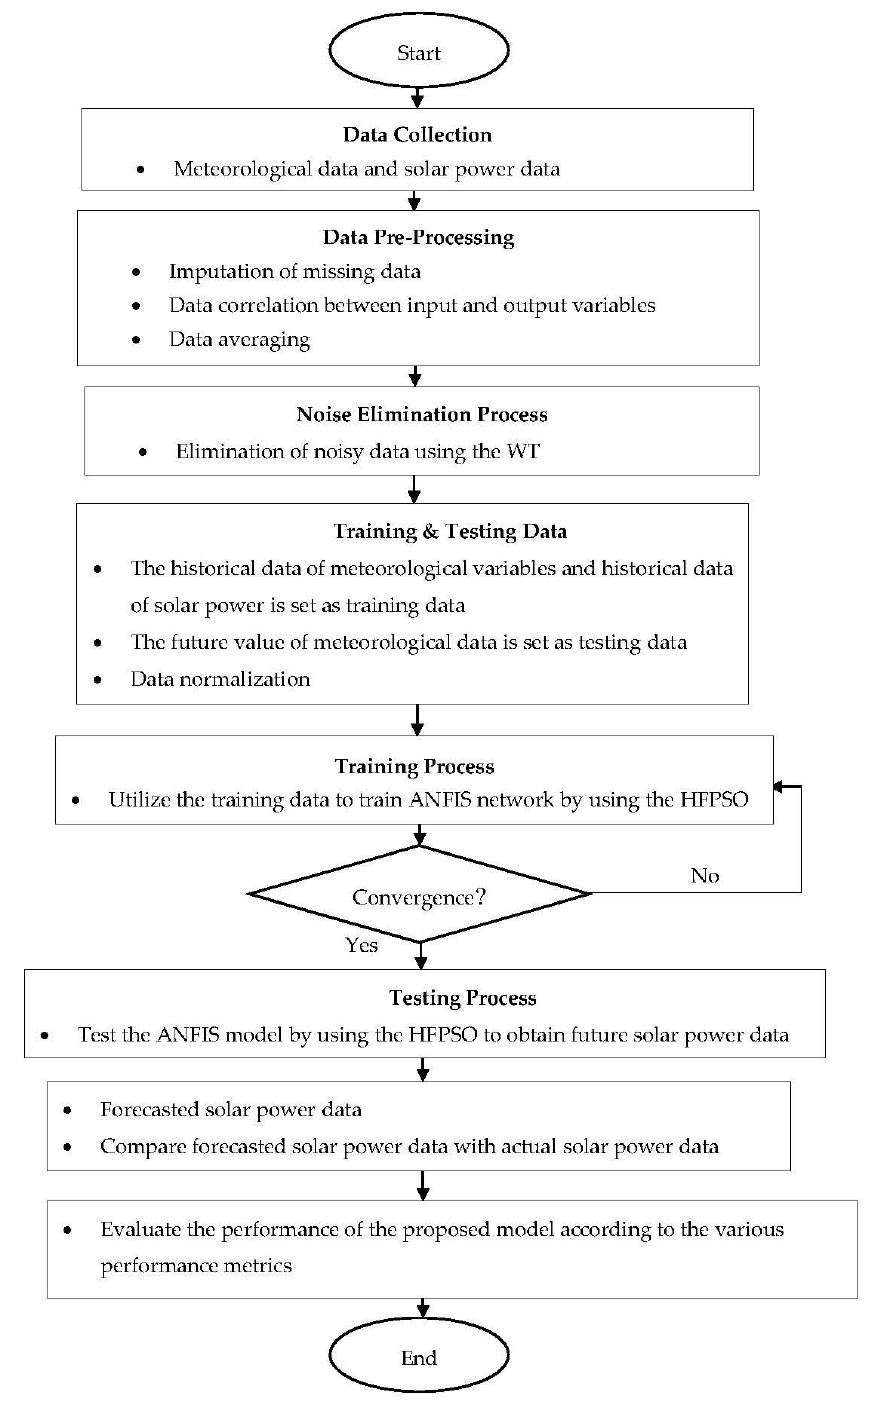
Figure 1. Implementation of forecasting strategy.